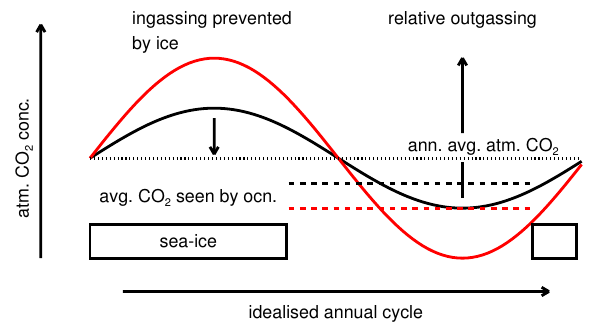
Fig. 7. Explanation of how a change in the magnitude of the atmo- spheric CO 2 seasonal cycle can change the air-sea CO 2 flux in sea- sonally sea-ice covered waters. During the year, high atmospheric CO 2 concentrations occur around the time of maximum ice-cover, and are therefore prevented from exchanging freely with the ocean, whereas at times of low atmospheric CO 2 concentration, there ex- ists no barrier to exchange. The result of this synchronicity between the seasonal cycles of atmospheric CO 2 concentration and sea-ice extent is that the annually averaged atmospheric CO 2 concentration seen by the ocean is reduced relative to that its full annual mean value, as the amplitude of the atmospheric CO 2 seasonal cycle is increased. The solid black and red curves represent the idealised an- nual cycles in atmospheric CO 2 concentration at one and two times the seasonal cycle amplitude respectively. The dotted black line rep- resents the full annually averaged atmospheric CO 2 concentration. The dashed black and red lines represent the partial average of at- mospheric CO 2 concentrations for the two different seasonal cycle amplitudes, over the ice-free